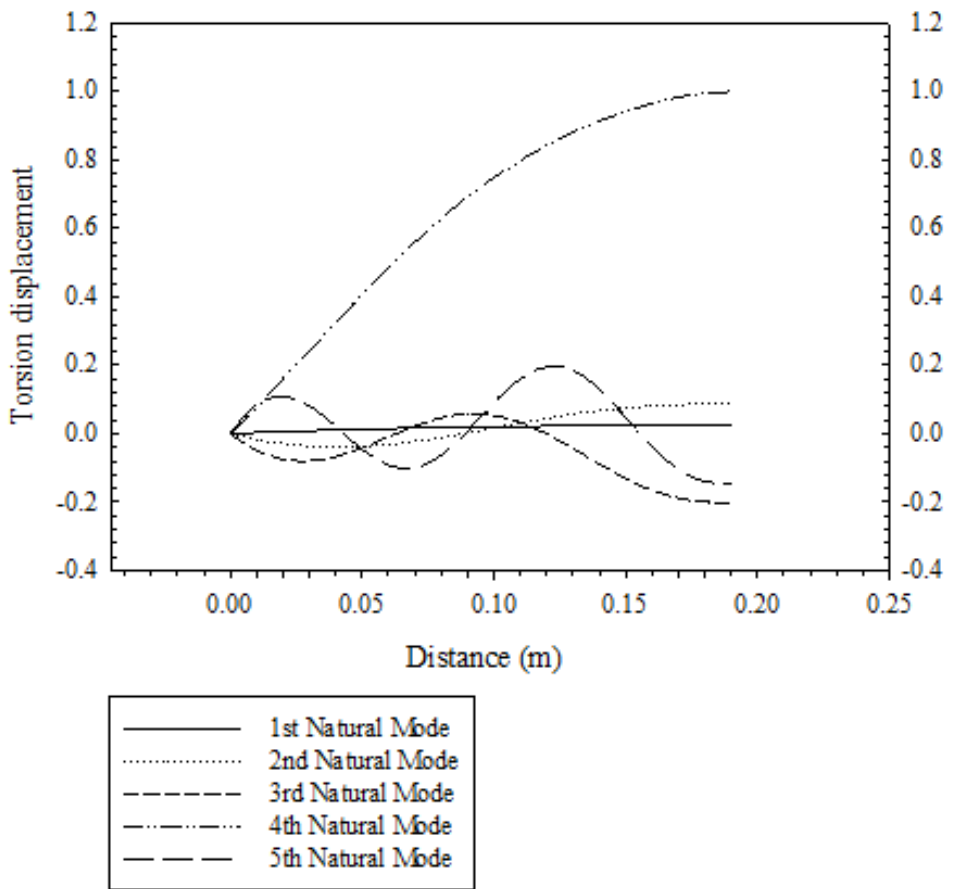
Figure 8. The torsion components for the first five natural mode shapes, obtained using the DFE method (torsion displacement is normalized).